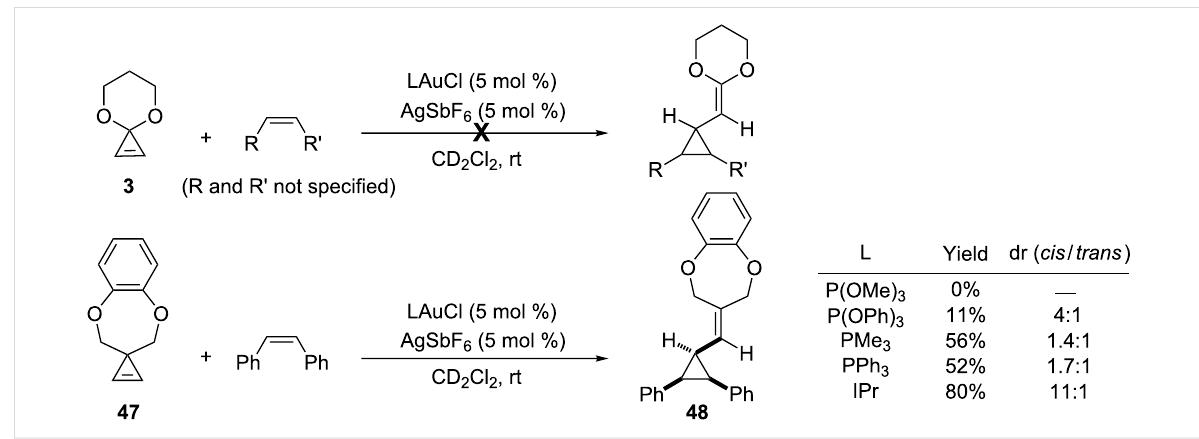
Scheme 22: Intermolecular olefin cyclopropanation with gold carbenes generated from